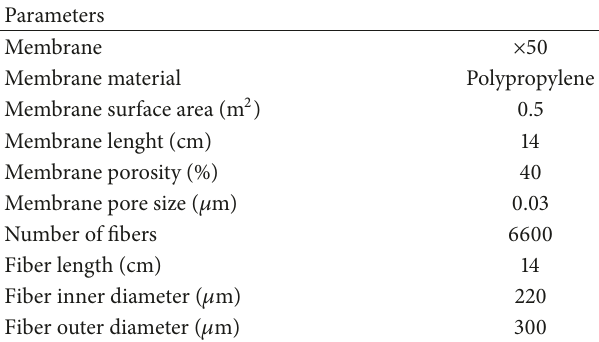
Table 2: Membrane module (1.7 × 5.5 MiniModule, Liqui-Cel)